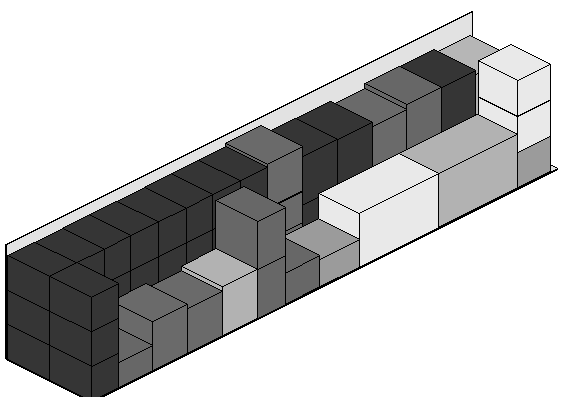
Figure 1. A container loading pattern with orientation and stability